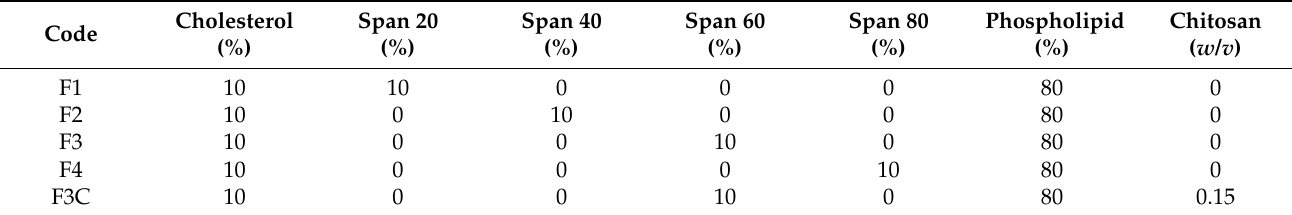
Table 1. Formulation composition of IPI vesicles and IPI chitosan